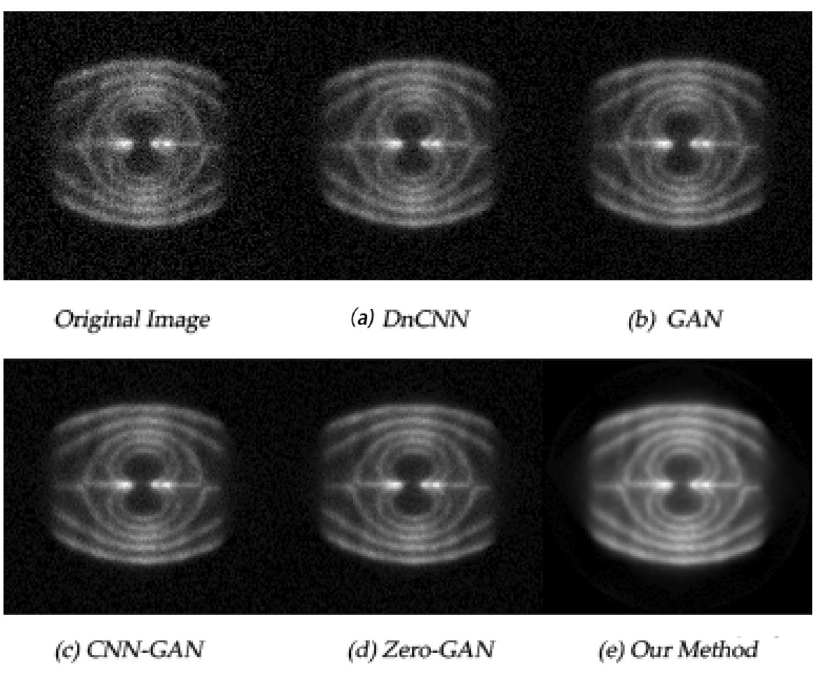
Figure 8. Fluid diagram of intertnal fluid in engine